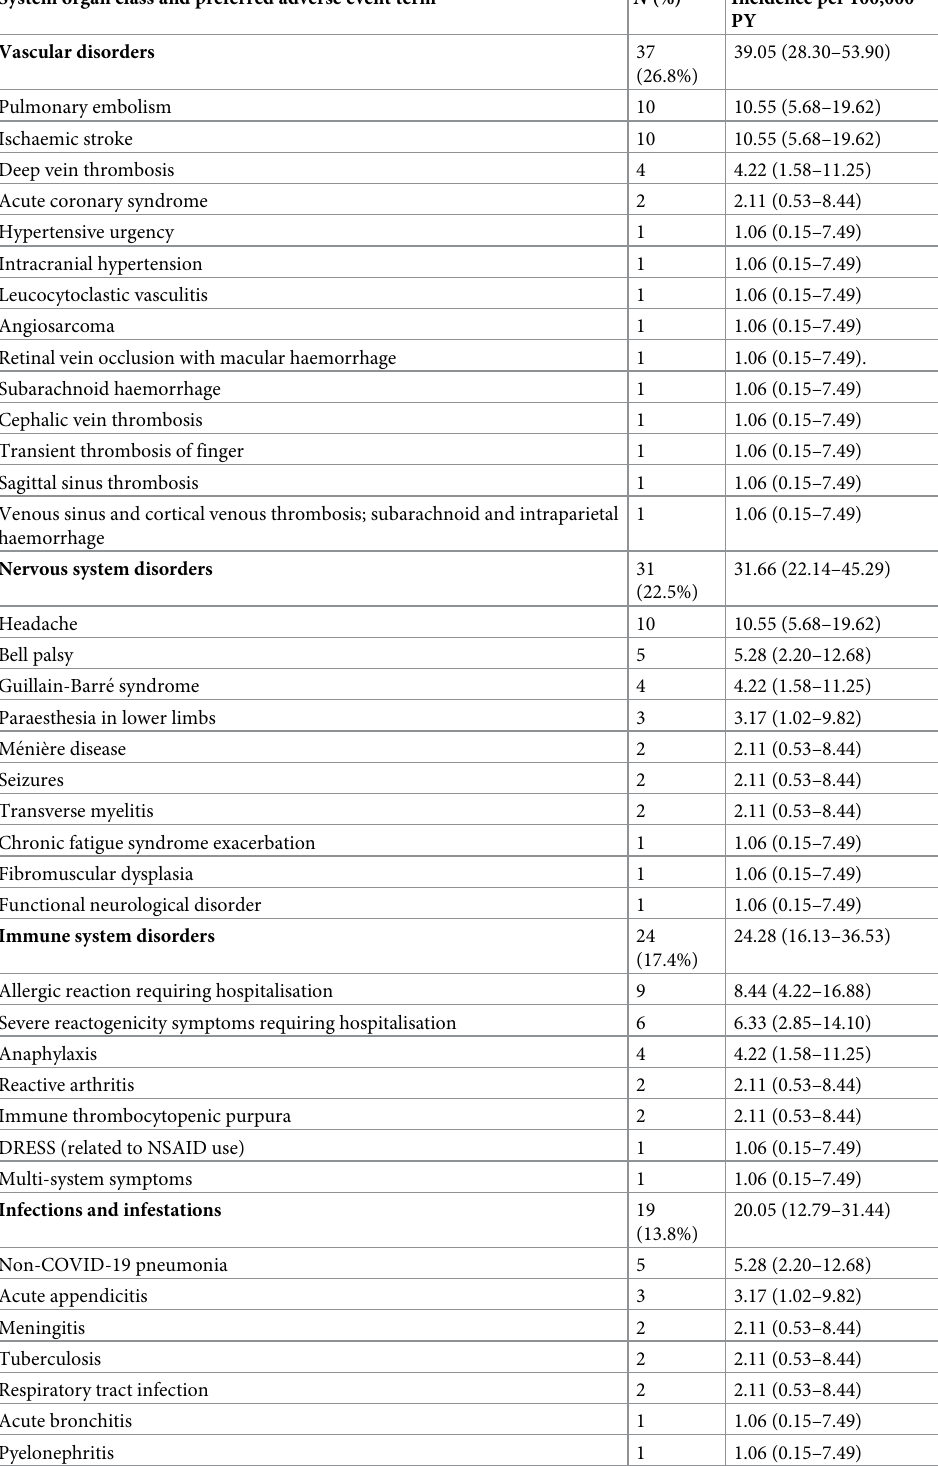
Table 2. Serious adverse events by Medical Dictionary for Regulatory Activities (MedDRA) system organ class and preferred adverse event term ( n =